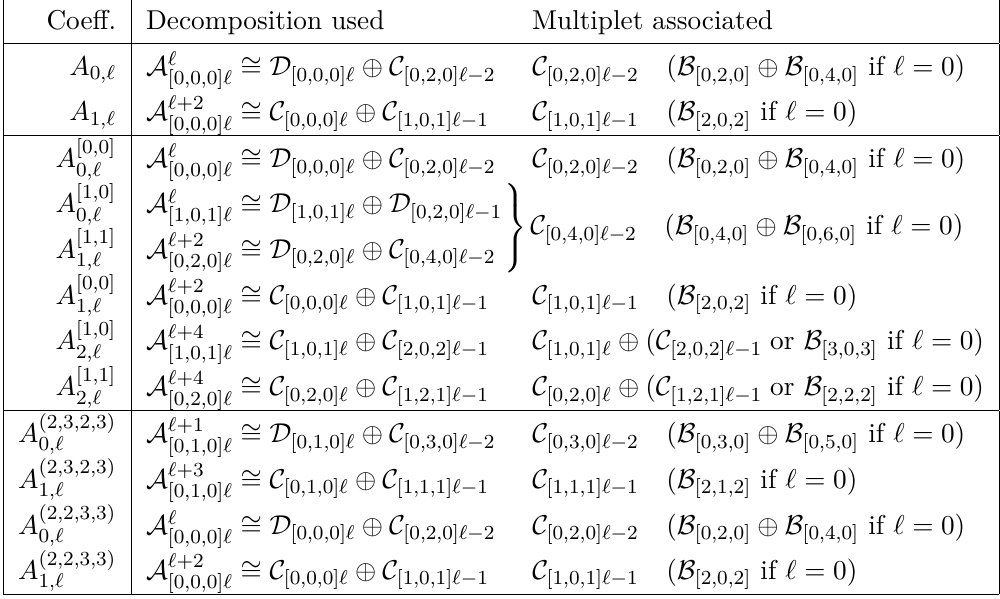
Table 1. Summary of semishort multiplets arising from the recombination described in the previous paragraphs. Now the notation [ n, m ] ≡ [ n − m, 2 m + p 43 , n − m ] has been expanded in order to avoid confusion. These results can be found in [45] and appendix D of